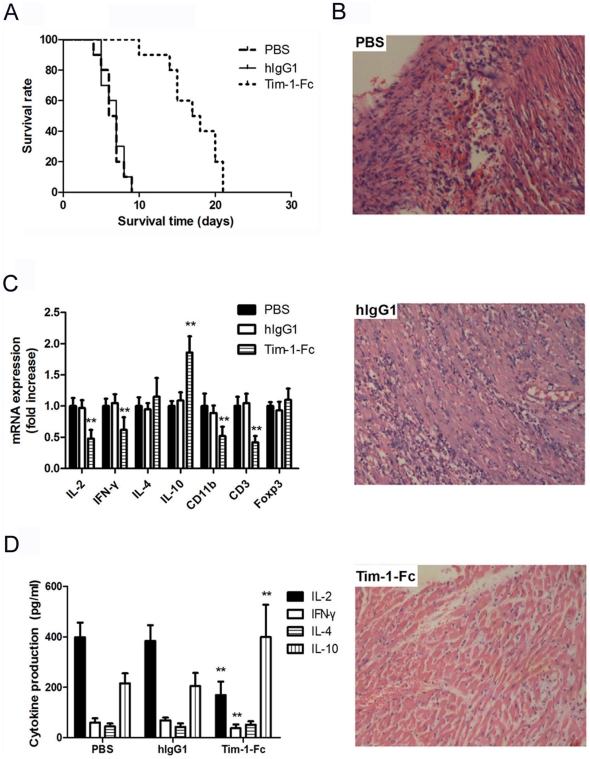
Tim-1-Fc prolongs cardiac allograft through inhibiting Th1 cytokines expression and leukocytes infiltration.Heterotopic heart grafts were transplanted from BALB/c mice into C57BL/6 recipients. The recipients were treated with PBS (n = 10), hIgG1 (10 mg/kg, n = 10) or Tim-1-Fc (10 mg/kg, n = 10) starting on post operation day (POD) 0 for seven consecutive days. Rejection was defined as cessation of a palpable impulse. Survival rates were compared using log-rank test (A). Hematoxylin eosin staining (B) of representative heart allografts harvested at POD 7 from mice treated with PBS, control hIgG1 or Tim-1-Fc (original magnification ×200). Cardiac allografts and blood were harvested on POD 7 from recipients. Intragraft expression of IL-2, IFN-γ, IL-4, IL-10, CD11b, CD3 and Foxp3 mRNA was measured by RT-PCR (C) and normalized against GAPDH. Serum levels of IL-2, IFN-γ, IL-4 and IL-10 were tested by ELISA (D). *P<0.05, ** P<0.01 in comparison with controls.